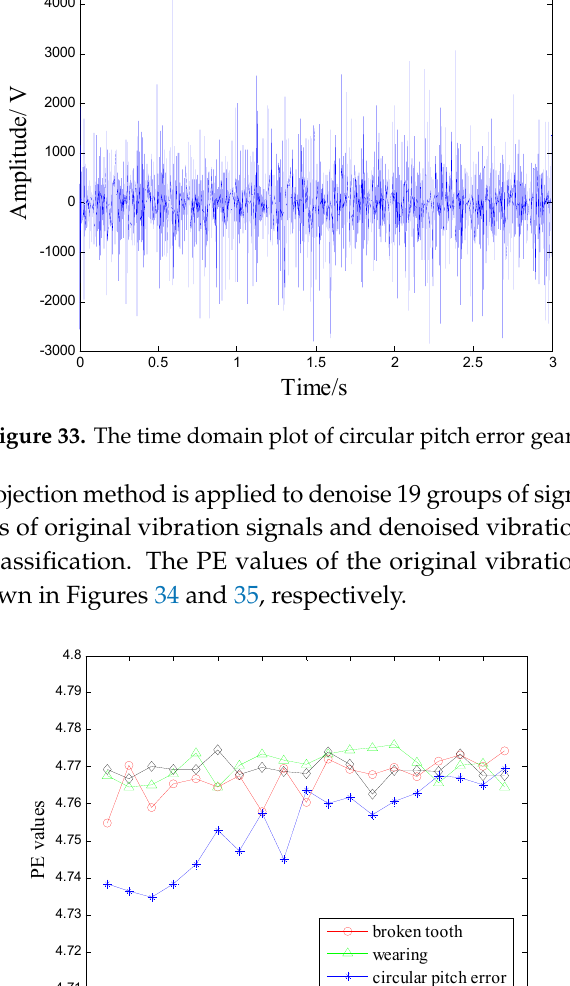
Figure 35. The permutation entropies of the proposed approach. Through the PE values of original signals and denoised signals above, it can show that before the smooth local subspace projection denoising, the PE values of one working condition are not distinguished from another working condition. All the PE values are aliasing, as shown in Figure 34. However, after the gear vibration signals are denoised by the local projection method, the entropies of gear signals of four kinds of working conditions are distinguished very clearly. As shown in Figure 35, the permutation entropies of vibration signals of broken gears are the smallest, ranging from 3.47 to 3.60, and their mean value is 3.54; the permutation entropies of the vibration signals of wearing gear range from 3.71 to 3.84, and their mean value is 3.75; the permutation entropies of vibration signals of normal gear range from 3.78 to 3.90, and their mean value is 3.85; the permutation entropies of circular pitch error gears are the biggest, and range from 3.90 to 4.08, and their mean value is 3.99. The PE values of different fault types have different mean value and range, which can be applied to classify different kinds of mechanical fault signals. Hence, gears with different kinds of defects can be classified by the proposed method based on the proposed smooth local subspace projection method using the logarithmic weighting function and PE. To sum up, the application researches demonstrate the effectiveness of the proposed method in the fault classification of gears. 5. Conclusions The research work in this paper elaborates on the theoretical effectiveness of the proposed method based on the smooth local subspace projection and PE. The new weight matrix also proves